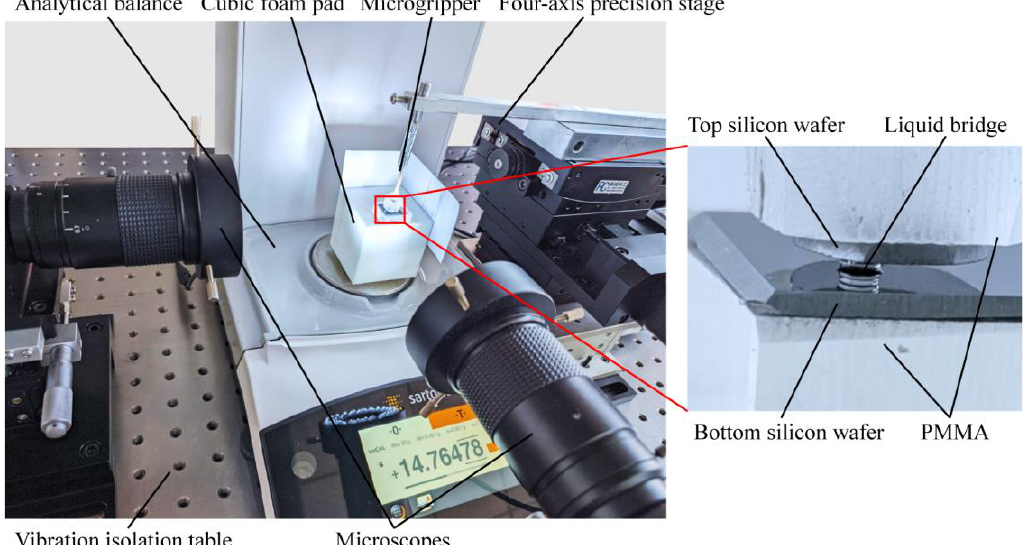
Figure 4. Experimental setup. Table 1. Experimental liquids and physical properties.